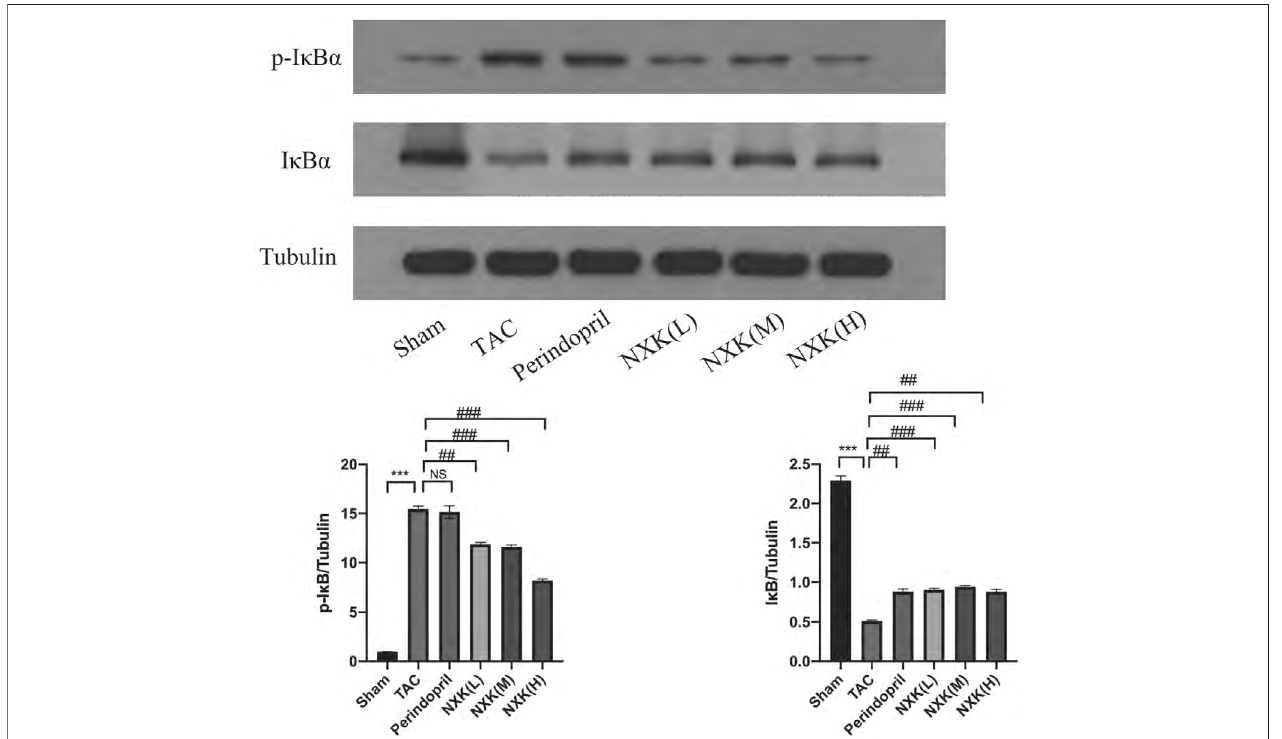
FIGURE5| WesternblotanalysiswasusedtomeasuretheproteinlevelsofI κ B α andP-I κ B α .ExpressionlevelsofI κ B α andP-I κ B α proteinsindifferentmicegroups ( n = 6 per group). Quanti fi cation was performed after normalization to Tubulin. Values are shown as means ± SD, compared to the sham group * p < 0.05, ** p < 0.01, *** p < 0.001, compared to the Tac group # p < 0.05, ## p < 0.01, ### p < 0.001.